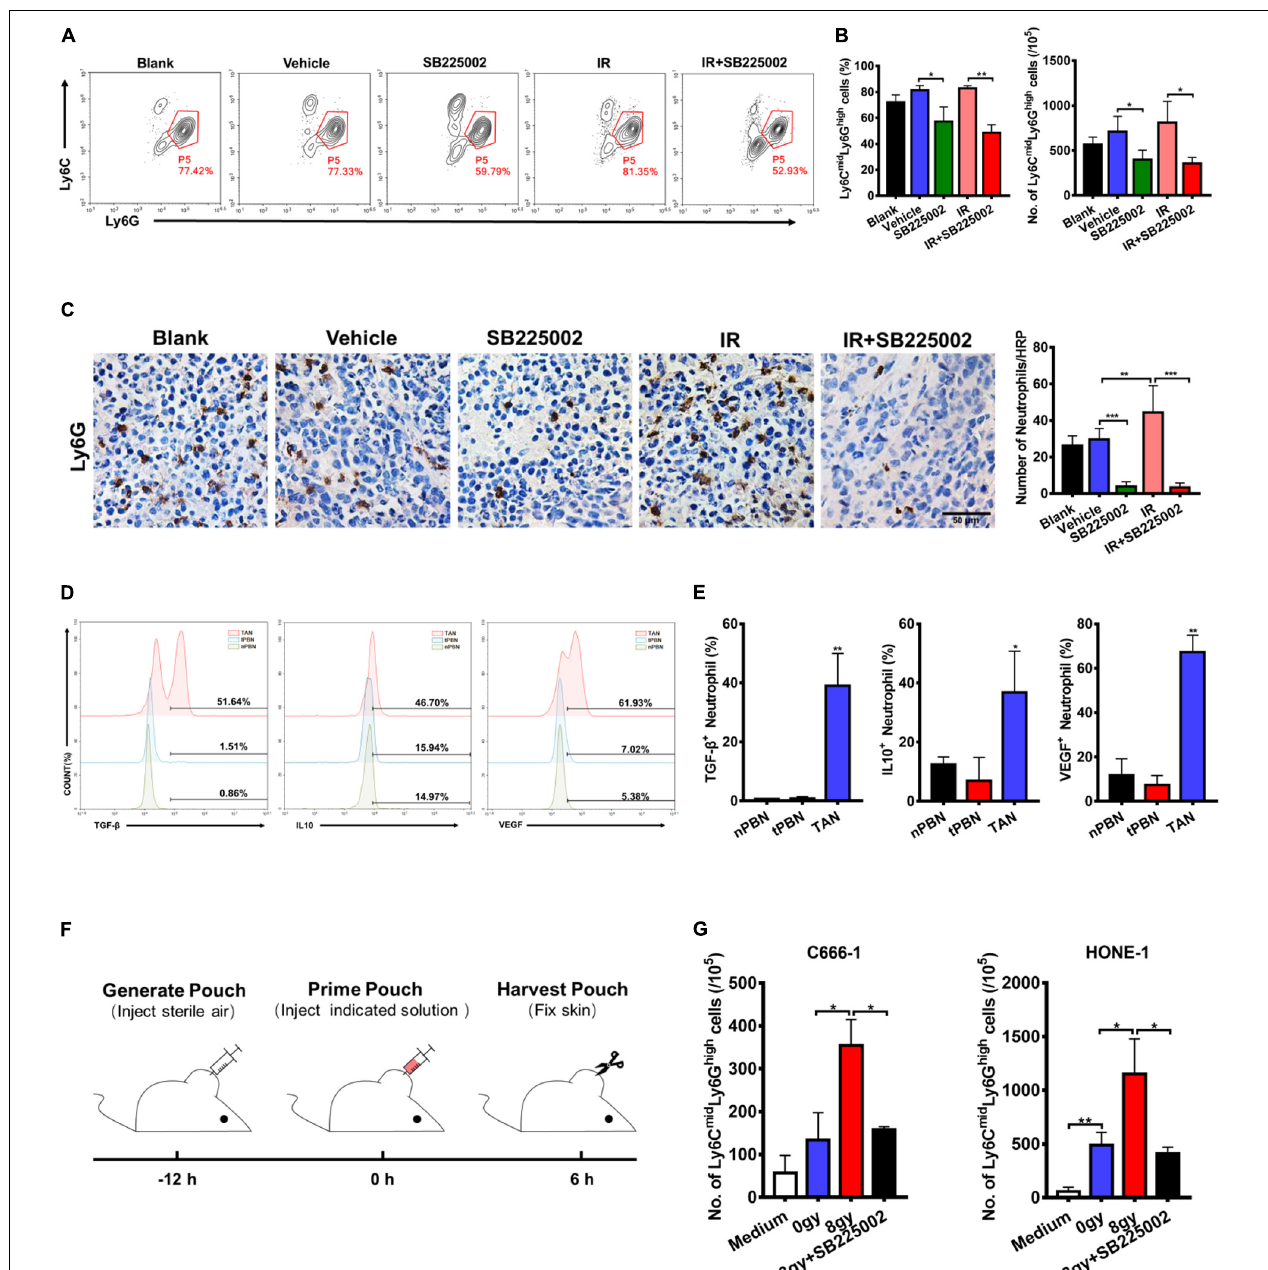
FIGURE 5 | Effects of SB225002 on recruitment of TANs in vivo . (A) SB225002 significantly reduced TANs in C666-1 tumor-bearing nude mice. Total numbers of 10,000 cells gated on CD45-positive cells were collected and CD45 + CD11b + Ly6C mid Ly6G high cells were gated as TANs. Numbers illustrated indicate the percentage of the cells. (B) Flow cytometry analysis quantified TANs in tumor at the end of treatment with SB225002 combined radiotherapy. The percentage of TANs and the absolute number of TANs were shown as mean ± SD ( n = 4; * p < 0.05; ** p < 0.01; Student’s t -test). (C) TAN was assessed on paraffin-embedded C666-1 tumor sections by Ly6G immunohistochemical staining after SB225002 combined radiotherapy treatment. Representative immunohistochemistry images showing Ly6G-positive TANs in the xenograft tumors in five groups. Scale bar, 50 mm. Image analysis data for Ly6G-positive TANs were shown as mean ± SD ( n = 3 animals each group, ** p < 0.01; *** p < 0.001; Student’s t -test). (D,E) Intracellular flow cytometry detected the increased secretion of TGF- β , IL-10 and VEGF by Ly6G-positive neutrophils in C666-1 tumors (TAN) compared with the neutrophils in peripheral blood from both non-tumor bearing mice (nPBN) and C666-1 tumor-bearing mice (tPBN). Total numbers of 10,000 cells gated on CD45-positive cells were collected and the CD45 + CD11b + Ly6C mid Ly6G high cells in tumor were gated. Numbers illustrated indicate the percentage of the cells ( n = 3; * p < 0.05; ** p < 0.01; Student’s t-test). (F) Schematic representation of the experiment sequence in air pouch experiments of recruitment of neutrophils stimulated by supernatants of irradiated tumor cells in vivo . (G) Flow cytometry analysis quantified neutrophils recruitment into the air pouch skin samples. Air pouch skin samples were collected at the indicated time point, and neutrophils were analyzed by flow cytometry. Total cell numbers per 10 5 cells are shown. Means ± SD are depicted ( n = 3; * p < 0.05; Student’s t -test).